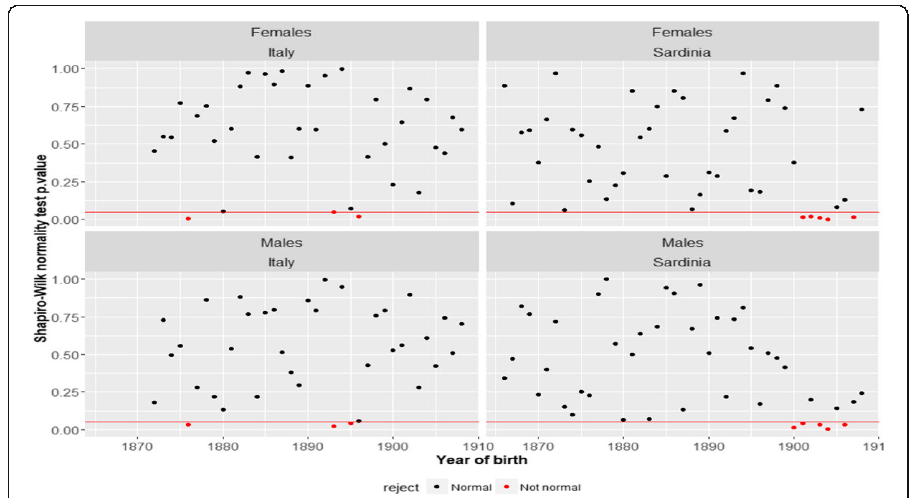
Fig. 9 Models diagnostic. Note : Each point represents the p value associated with the Shapiro-Wilk normality test. The (red) points below the threshold of 0.05 (red horizontal line) indicate those cases when the hypothesis of normality is rejected. Source : ISTAT and